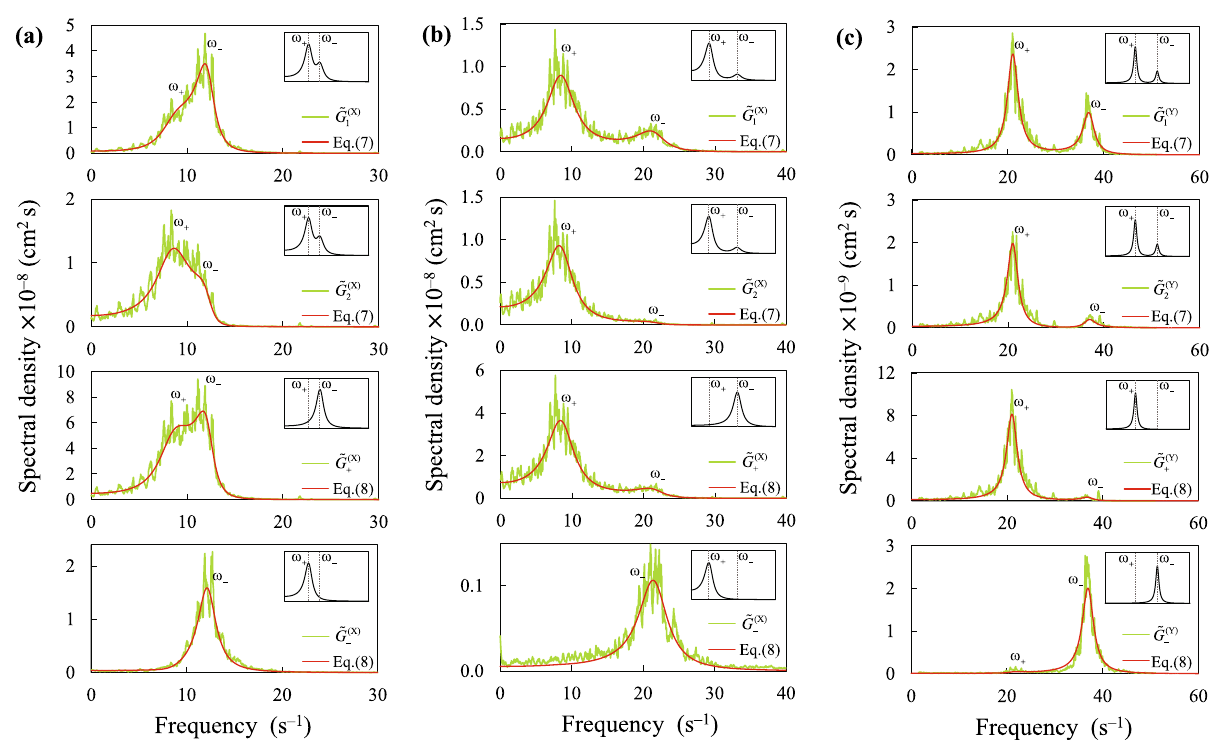
Figure 3. Spectral densities ˜ G 1 , 2 , − of the oscillations of particles ( a ) in the horizontal direction ( ξ ≡ X ) for a gas pressure P of 136 mTorr and a discharge power W of 4 W; ( b ) – ξ ≡ X , P = 136 mTorr, W = 14.3 W; ( c ) in the vertical direction ( ξ ≡ Y ) at P = 70 mTorr, W = 14.3 W; and their analytical approximations by Eqs. (7) and (8) from “Methods”. For comparison, schematic distributions of the corresponding spectral densities for particles interacting with a purely repulsive spherically symmetric potential are shown in the inserts. Spectral peaks correspond to oscillations at characteristic frequencies ω − and ω + . (Note that the characteristic frequencies coincide with the eigen frequencies of the system at zero